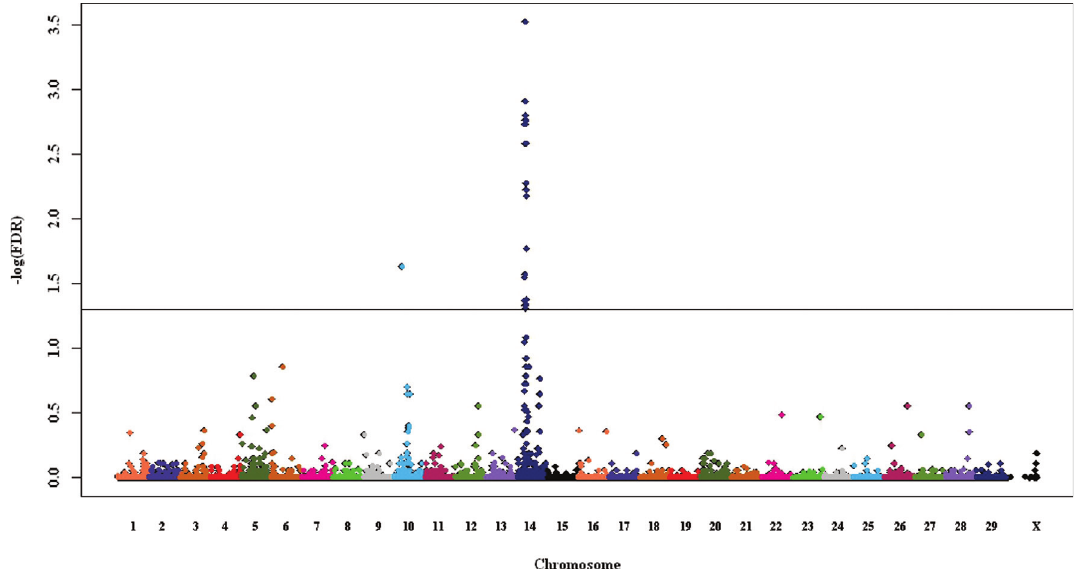
Figure 6 - Weaning weight-SNP marker associations by significance (-log[FDR] = 1.3 at the horizontal line) and